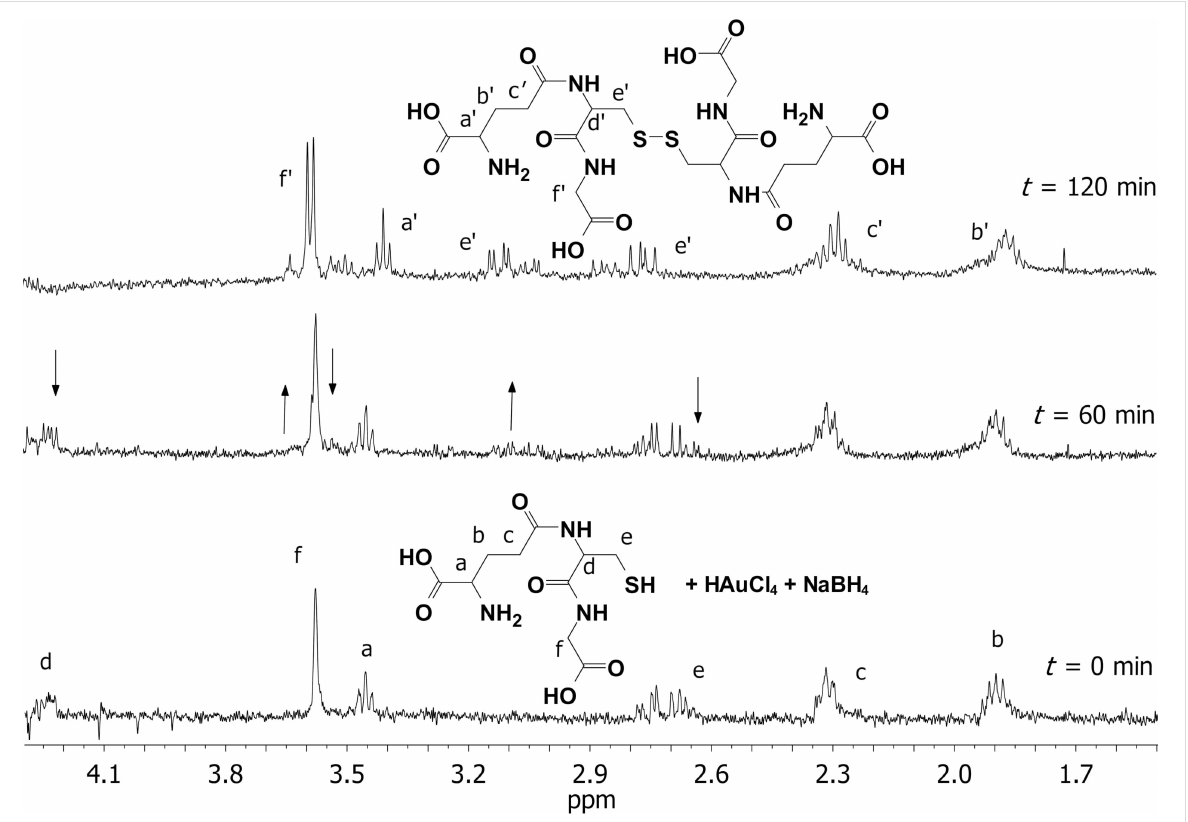
Figure 2: 1 H NMR spectra of the reaction mixture aliquots (5.6 mM glutathione, 56 mM NaBH 4 , and 5.6 mM HAuCl 4 , in ultrapure water/D 2 O added) taken at several time points. The arrows show how proton signals (for GSH and GSSG) change with time.